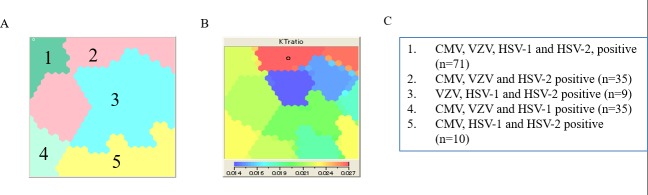
Clustering of human herpes virus (cytomegalovirus, CMV; varicella zoster virus, VZV; Herpes Simplex Virus-1, HSV-1; Herpes Simplex Virus-2, HSV-2) by self-organizing map (SOM) on Kynurenine/ Tryptophan ratio (K/T ratio).(A) Clustering map of CMV, VZV, HSV-1 and HSV-2; (B) Feature map of K/T ratio, which was associated with no weight in the SOM analysis; (C) Combination of HHVs for the cluster A.